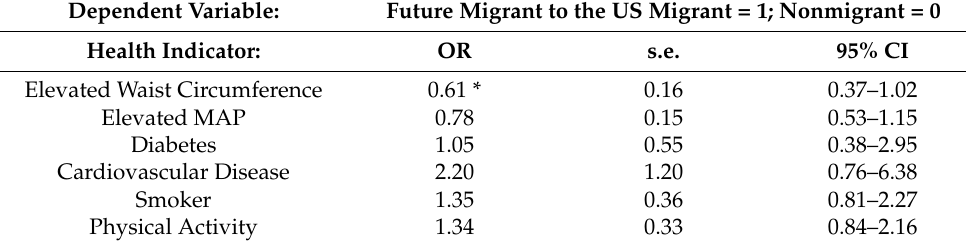
Table 2. Summary of Mixed-Effects Models of the Association between Cardiometabolic Health and Future Migration to the US, Wave 1, n =